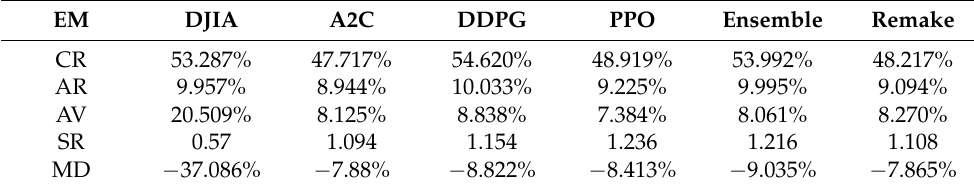
Table 1. Average performance of five RL-based agents on Dow Jones 30 stocks from 4 January